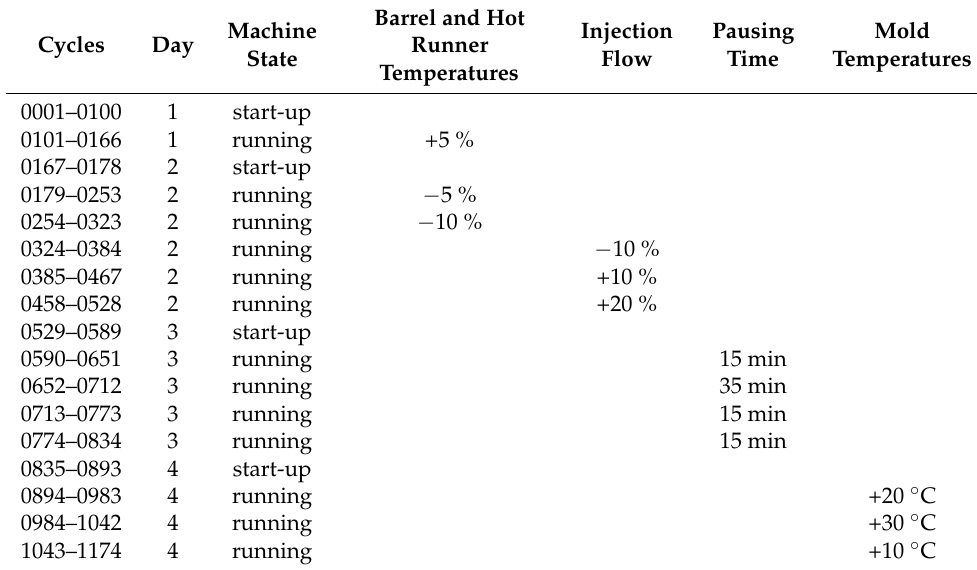
Table 1. Varied parameters for Housing Part data